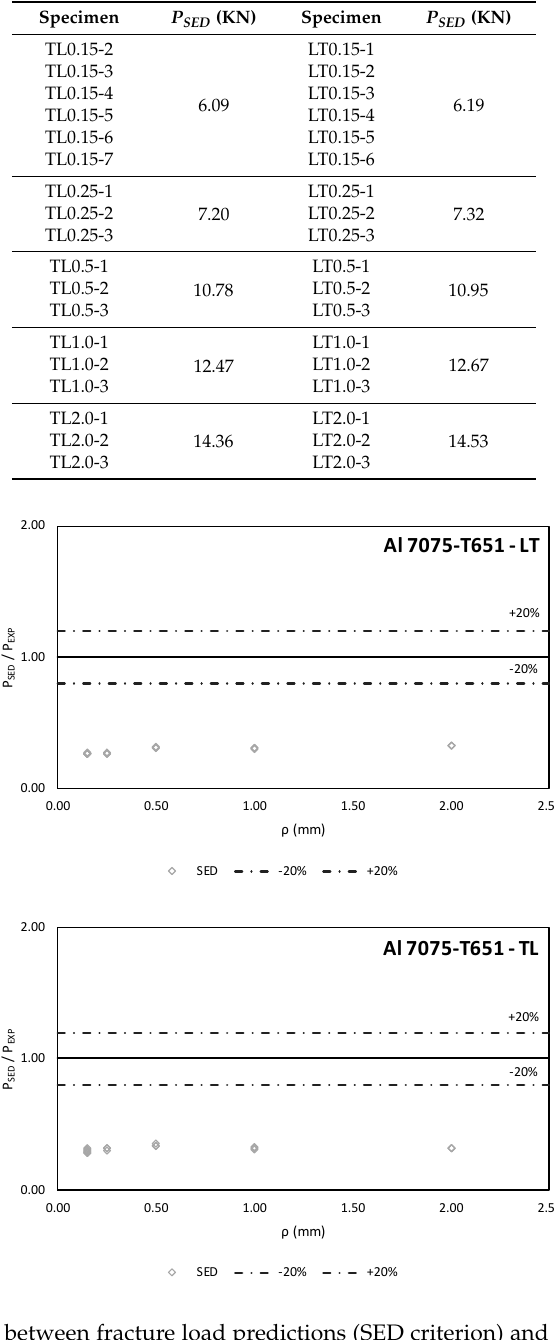
Figure 8. Comparison between fracture load predictions (SED criterion) and experimental fracture loads; ( a ) TL specimens; ( b ) LT specimens.